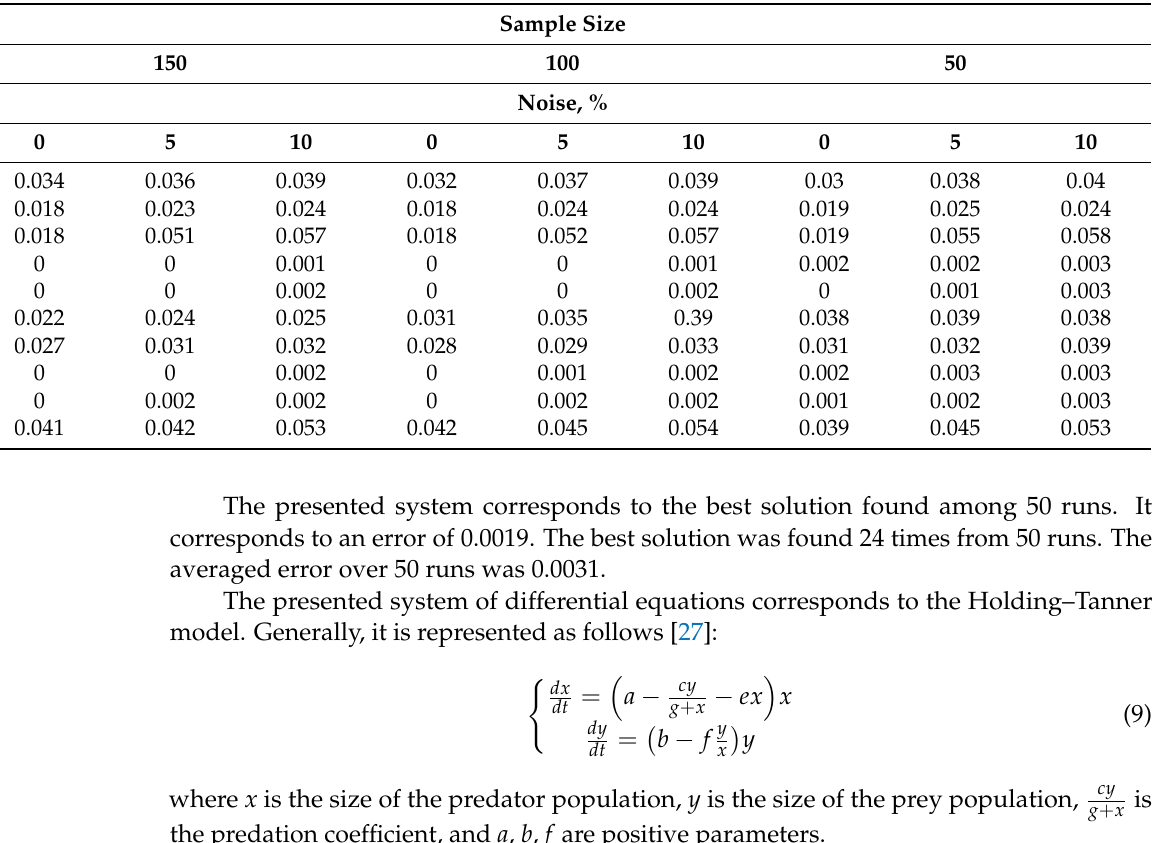
Table 4. Testing results of the evolutionary approach to the identification of dynamical systems in the form of an ODE system.